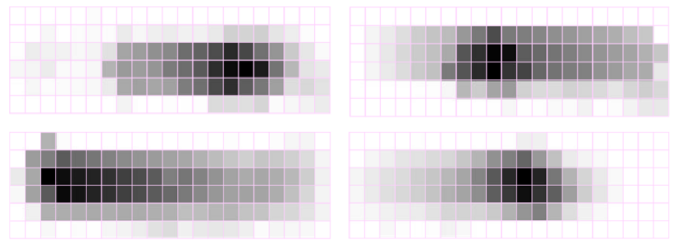
Figure 12. Example of target data for